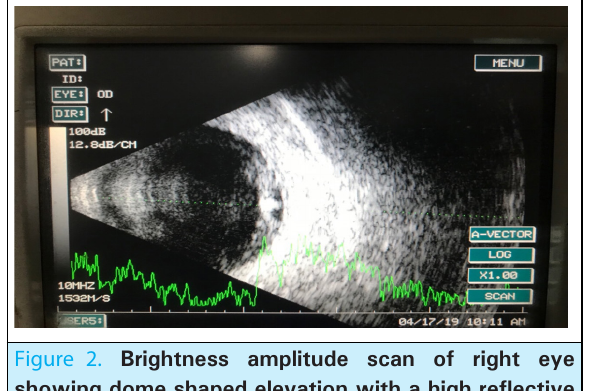
Figure 2. Brightness amplitude scan of right eye showing dome shaped elevation with a high reflective elevation at Inferotemporal quadrant suggestive of scolex.